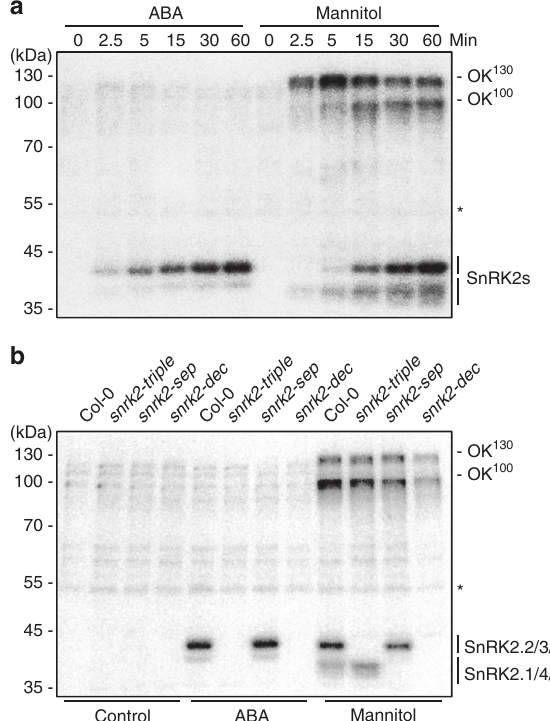
Fig. 1 Osmotic stress activates OKs and SnRK2s. a In-gel kinase assay showing the SnRK2, OK 100 , and OK 130 activities after the indicated time of treatment with 50 μ M ABA or 800 mM mannitol. b In-gel kinase assay showing the SnRK2, OK 100 , and OK 130 activities in wild type, snrk2.2/3/6 triple ( snrk2-triple ), snrk2.1/4/5/7/8/9/10 septuple ( snrk2-sep ), and snrk2.1/ 2/3/4/5/6/7/8/9/10 decuple ( snrk2-dec ) mutants after 30 min of ABA or mannitol treatment. Though it is reported that SnRK2.7 and SnRK2.8 are also activated by ABA treatment, their activation could not be clearly indicated in our in-gel kinase assay. Asterisk indicates a non-induced band that could be used as a loading control. Images shown are representative of three independent experiments. Source data are provided as Source Data fi